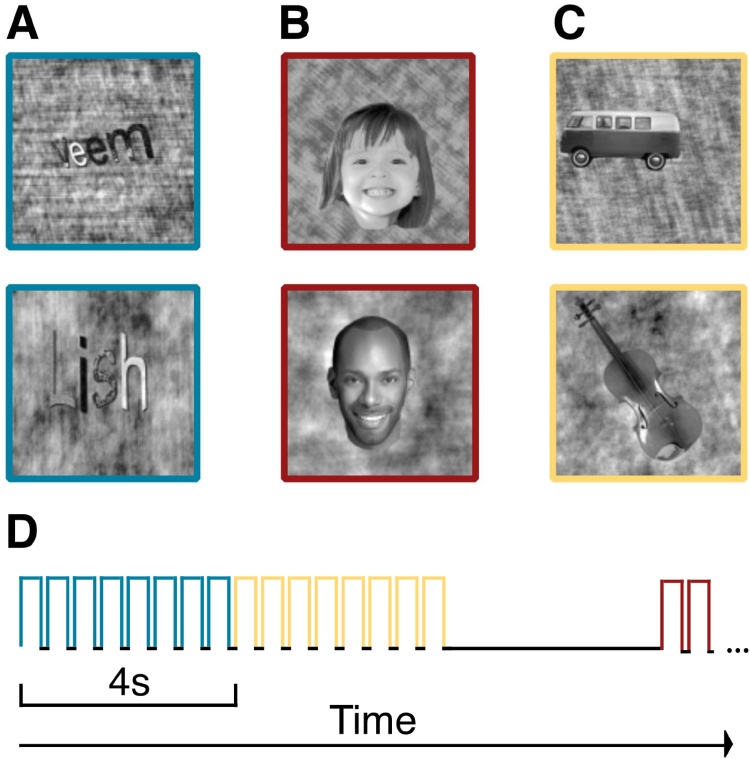
Example stimuli for each stimulus category. (A) Words. Four-letter pseudowords were presented during the word block. (B) Faces. Children and adults’ faces were shown during the face block. (C) Objects. Cars and musical instruments were displayed during the object block. (D) Timing of the functional localizer. In each categorical block, eight images were presented for 400 ms followed by 100 ms of fixation. Blank blocks (4 s of fixation) were randomly interleaved throughout the experiment. During the scan, subjects were instructed to fixate at the fixation mark in the center of display and performed a one-back task.